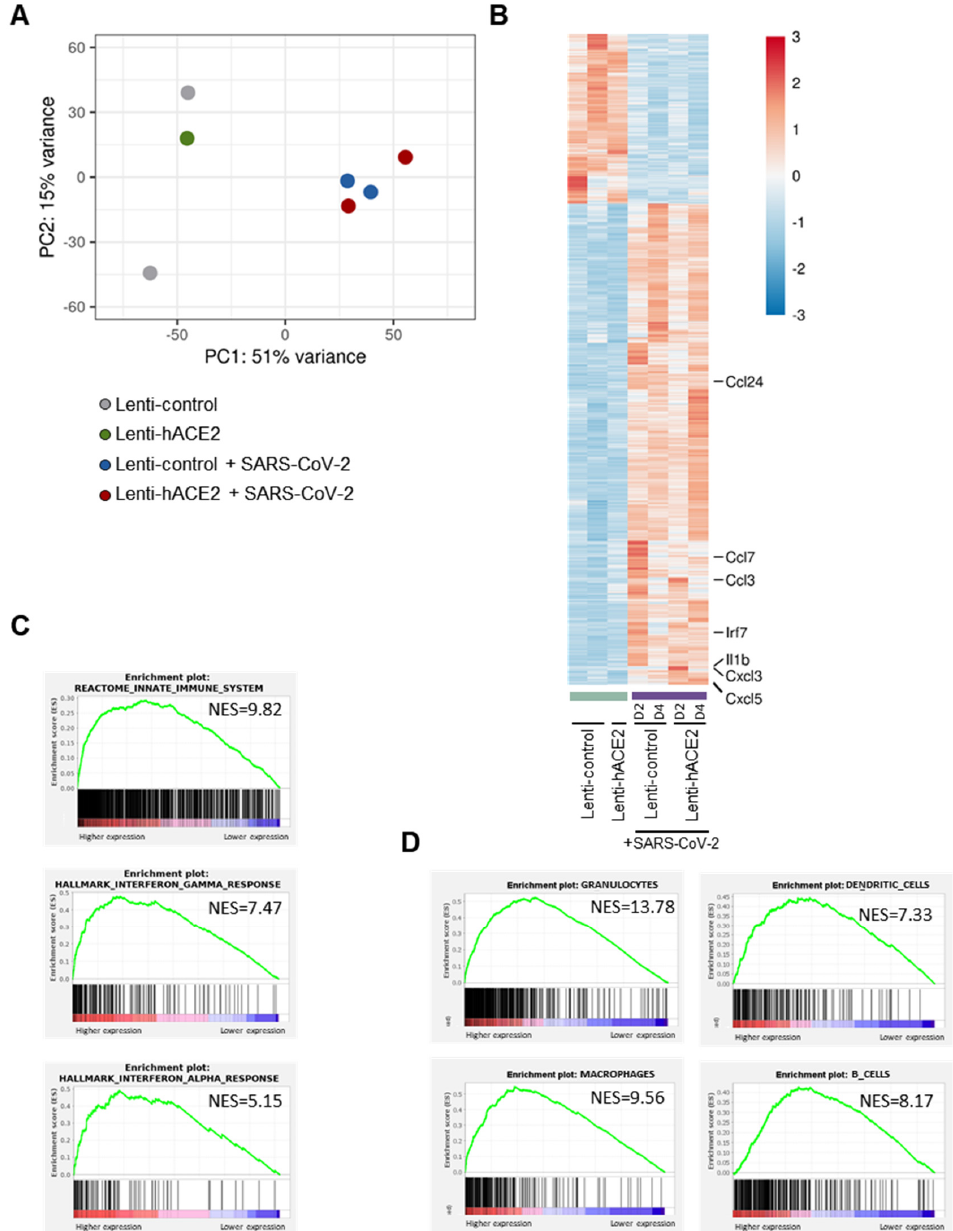
Figure 3. The exposure model: SARS ‐ CoV ‐ 2 infection elicits an immune response in IFNAR − / − mice. RNA ‐ seq data of lung homogenates collected from Lenti ‐ control ( n = 2), Lenti ‐ hACE2 ( n = 1), Lenti ‐ control infected with SARS ‐ CoV ‐ 2 ( n = 2; 1 at 2 dpi and 1 at 4 dpi) and Lenti ‐ hACE2 infected with SARS ‐ CoV ‐ 2 ( n = 2; 1 at 2 dpi and 1 at 4 dpi) mice. ( A ) Principal component analysis (PCA) of RNA ‐ seq data. ( B ) Heat map of significantly up ‐ and down ‐ regulated genes in Lenti ‐ control and Lenti ‐ hACE2 ‐ transduced SARS ‐ CoV ‐ 2 ‐ infected mice versus not infected controls. ( C ) Up ‐ regulated path ‐ ways in SARS ‐ CoV ‐ 2 ‐ infected mice vs. not infected controls according to Reactome and Hallmark collections, FDR < 0.001. ( D ) Immune cell subtypes enriched in lungs of SARS ‐ CoV ‐ 2 ‐ infected mice according to ImmGen classification, FDR < 0.001.